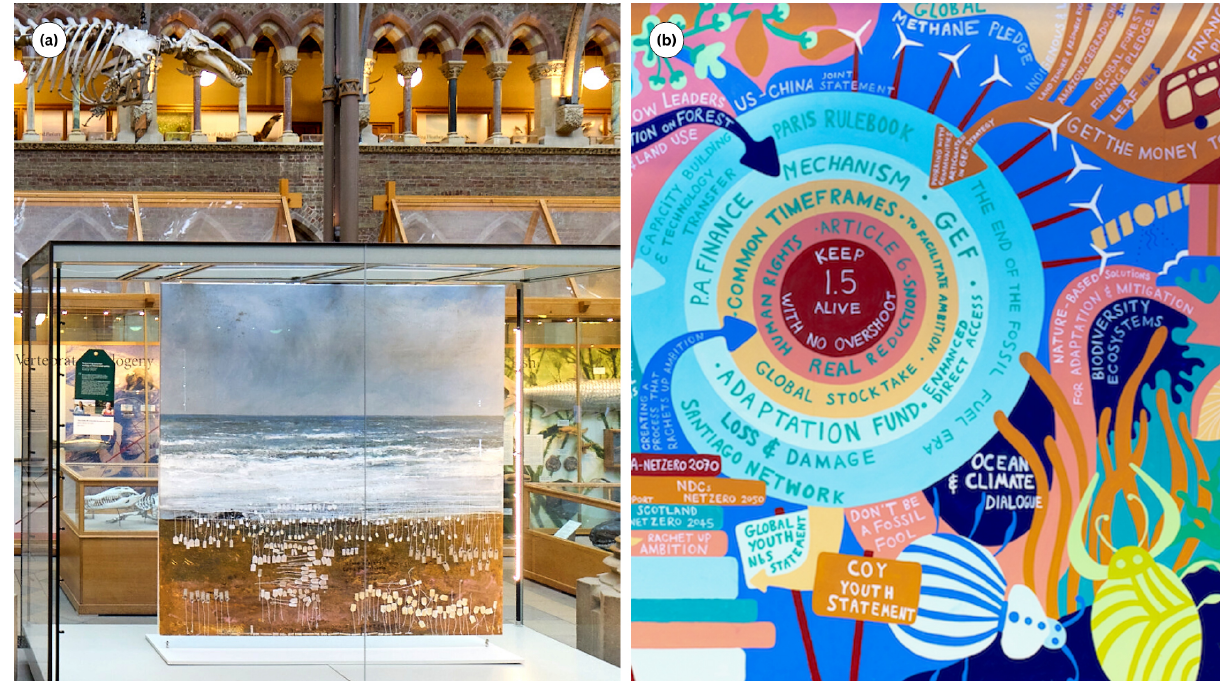
Figure 1. (a) Taxonomy of a Cornish Foreshore by Kurt Jackson, on display as part of the “Biodiversity” exhibition at the Oxford University Museum of Natural History. The piece shows how the beach, the foreshore, has a particular resonance to many whilst also being a biodiversity hotspot, a liminal zone, and the meeting point for ecosystems. This work was on display featuring a research re- sponse from authors Rosalie Wright and Lisa Wedding (see the Supplement). (Image credit: Museum of Natural History by Ian Wallman; https://iwphotographic.pixieset.com/museumofnaturalhistorybyianwallman/, last access: 20 March 2023.) (b) Cécile Girardin’s COP26 mu- ral capturing the COP26 conference proceedings. This piece was created with her team to communicate and engage wider audiences in the outcomes of the COP26 climate negotiations. (Image credit: Cécile Girardin; http://www.cecilegirardin.com/, last access: 1 October